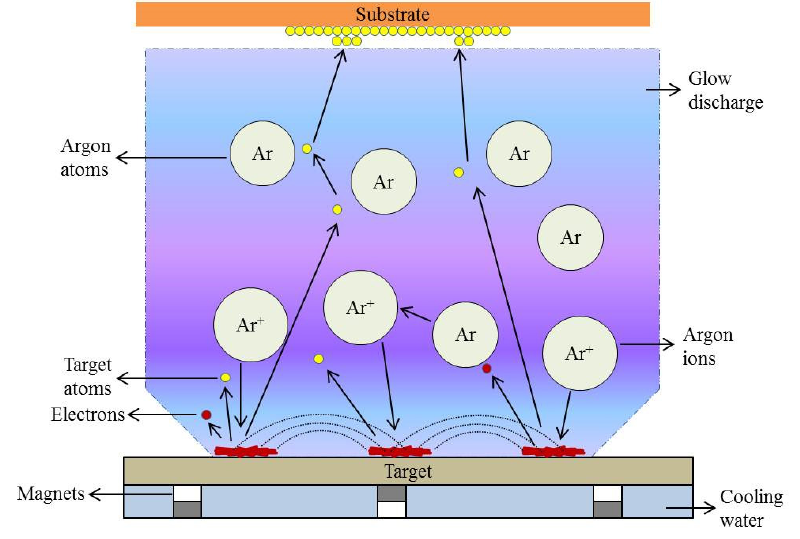
Figure 1. Schematic diagram illustrating the basic components of a magnetron sputtering